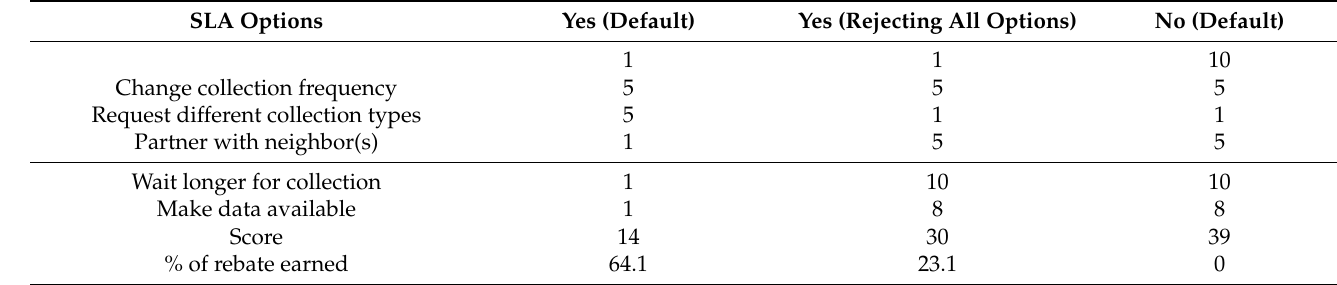
Table 2. Default customer scoring.